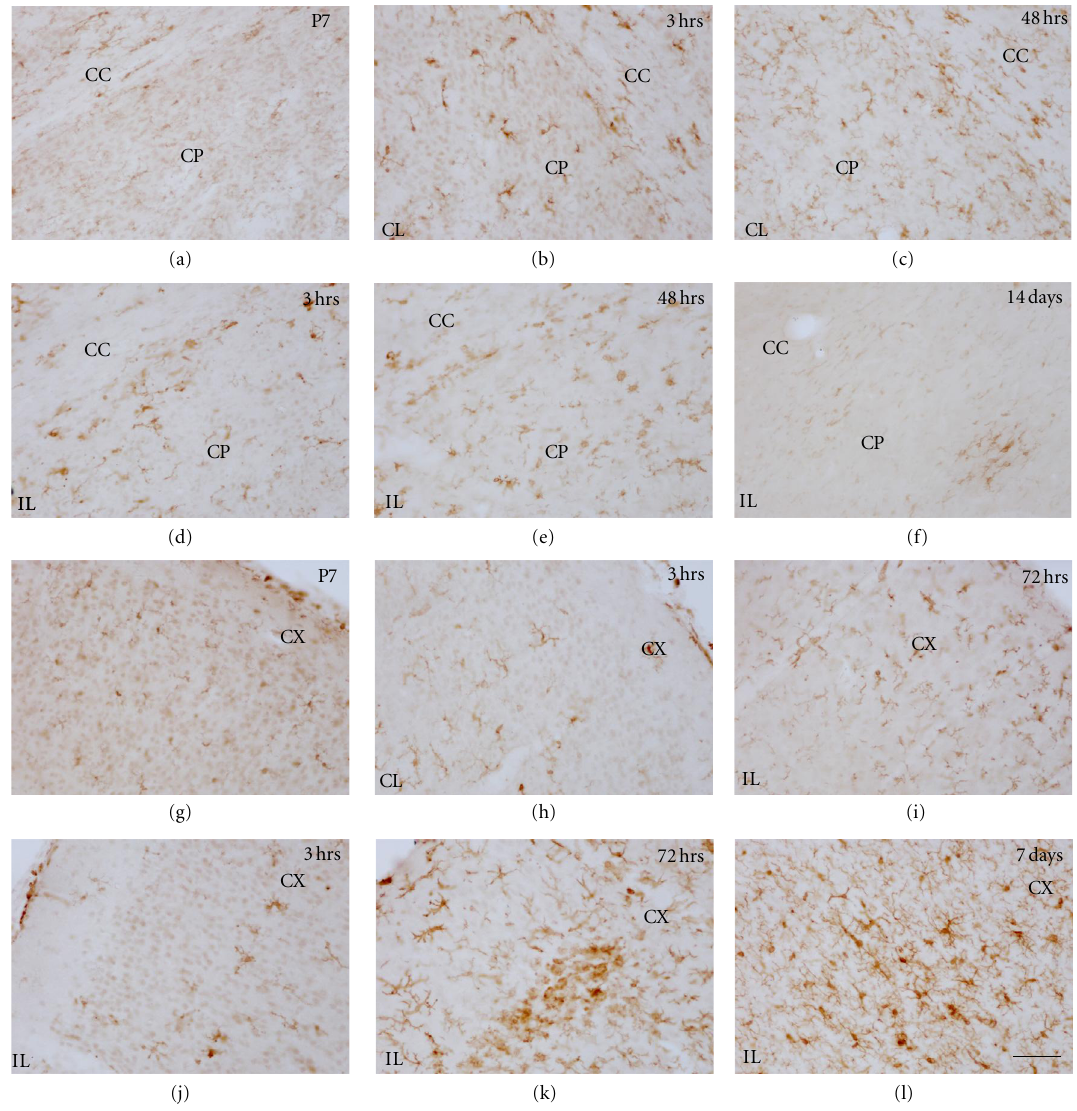
Figure 10: Iba-1 immunostaining in control animals and H/I e ff ects on the caudate-putamen (CP) (a–f) and neocortex (CX) (g–l). Control brain P7 shows basal expression of microglial Iba-1 in the CP (a) and CX (g). In the CP, activated microglia increase in the contralateral (CL) hemisphere at 3 hrs (b) up to 48 hrs (c). Higher activation is observed in the ipsilateral (IL) hemisphere at 3 hrs (d), showing a maximum at 48hrs (e), and slowly returns to resting morphology with some patches of activated microglia after 14 days (f). Similar pattern is observed in the neocortex, CL hemisphere shows di ff erential expression with respect to control animals from 3hrs (h) to 72hrs (i). Higher activation is observed in the ipsilateral (IL) hemisphere at 3hrs (j), a clear amoeboid patch pattern is observed in the neocortex after 72hrs (k), which slowly returns to resting morphology with some patches of primitive ramified microglia after 7 days (l). Scale bars: 50 μ